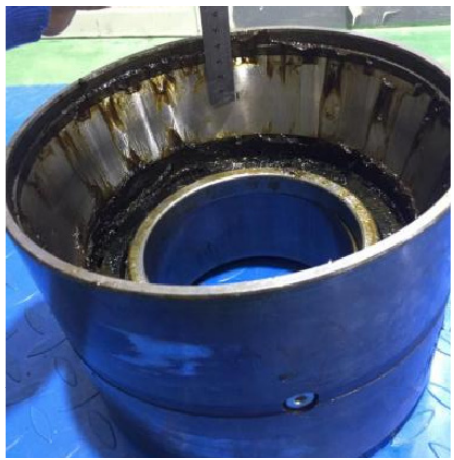
Figure 18. Weak fault morphology and the dimension of the outer ring of the axle box bearing. By selecting one of the above experimental conditions, namely 1800 r/min rotating speed and no-load experimental conditions, the performance of the pre-identification via singular value decomposition algorithm is verified. The time domain diagram of the collected vibration signal is shown in Figure 19. According to the bearing fault frequency calculated at the above different speeds, in view of the disadvantage of full signal section comparison in the above simulation signals, the experimental signals are mainly compared with the random selection and the manual visual